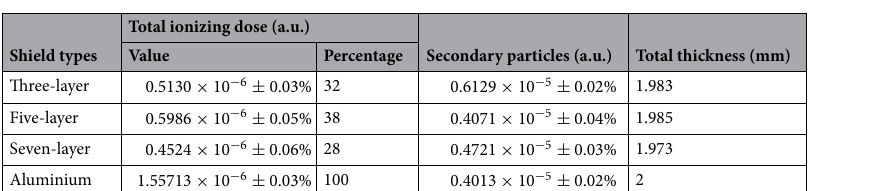
Total ionizing dose (a.u.) Shield types